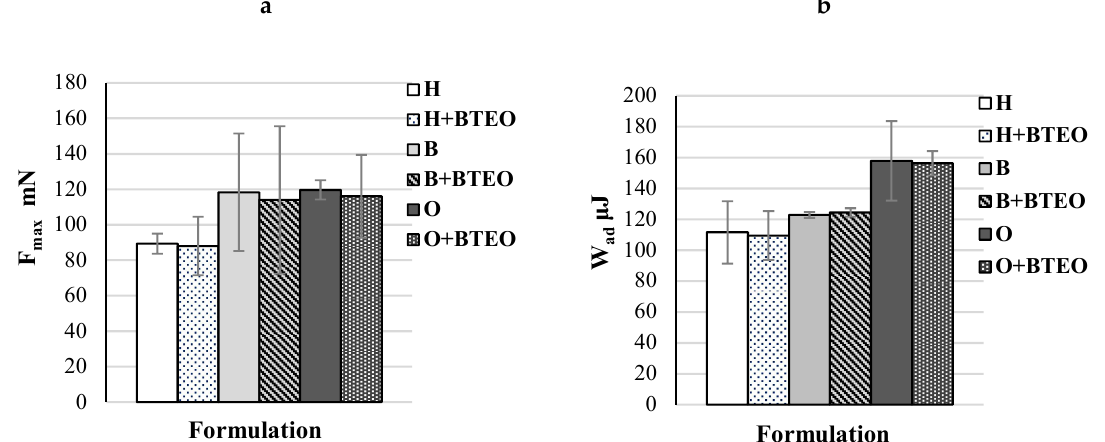
Figure 3. Ex vivo bioadhesive properties of formulations without (H, B, O) and containing essential oil of Bidens tripartita (H + BTEO, B + BTEO, O + BTEO) determined as maximum.detachment force F max ( a ) and work of adhesion W ad ( b ). Table 3. Antifungal activity of selected oleogel, bigel, and hydrogel-based formulations in combination with BTEO (100 mg/g) against Candida spp.